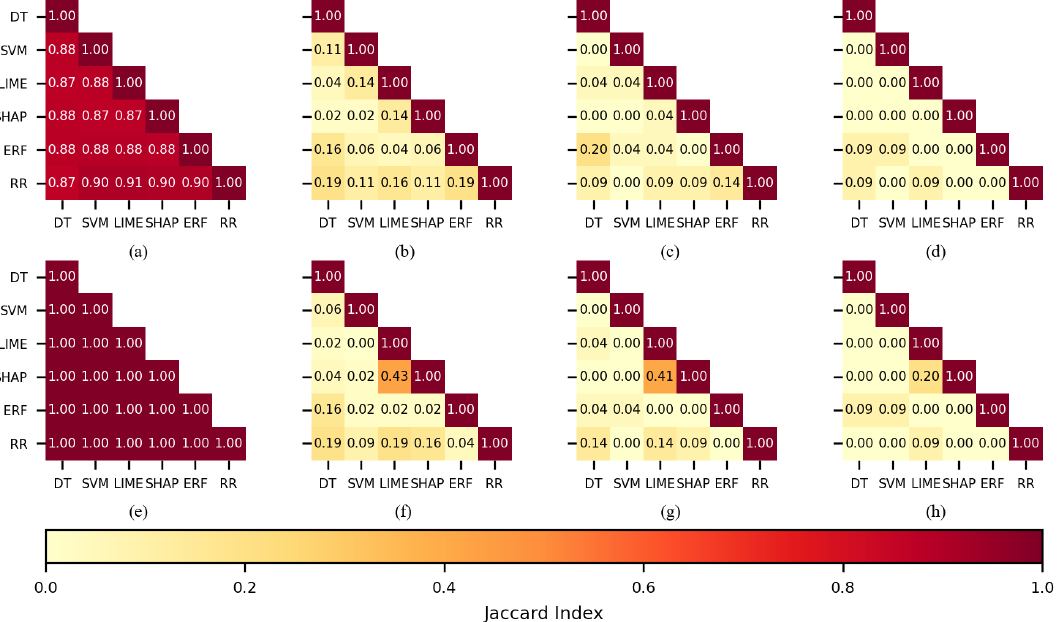
Figure 6. The similarity of the sets of features selected per each feature selection method when KNN was used as a classifier. CHB-MIT dataset: ( a ) best 450 features, ( b ) best 150, ( c ) best 100, and ( d ) best 50. Siena dataset: ( e ) best 450 features, ( f ) best 150, ( g ) best 100, and ( h ) best